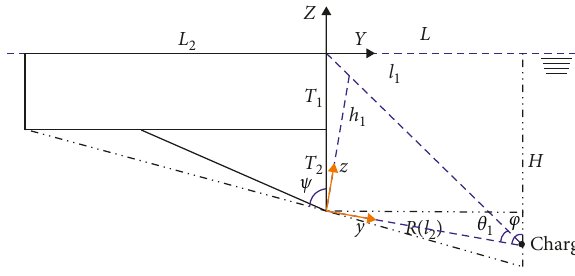
Figure 6: The condition at S